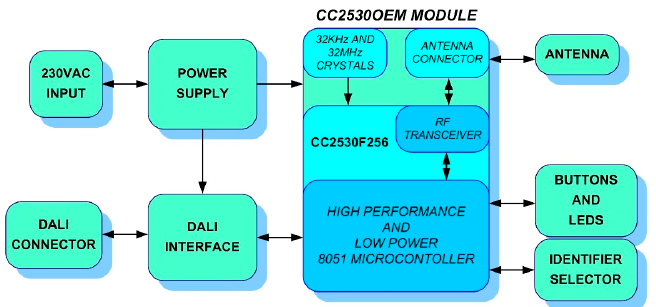
Figure 10. UCODALI block diagram.